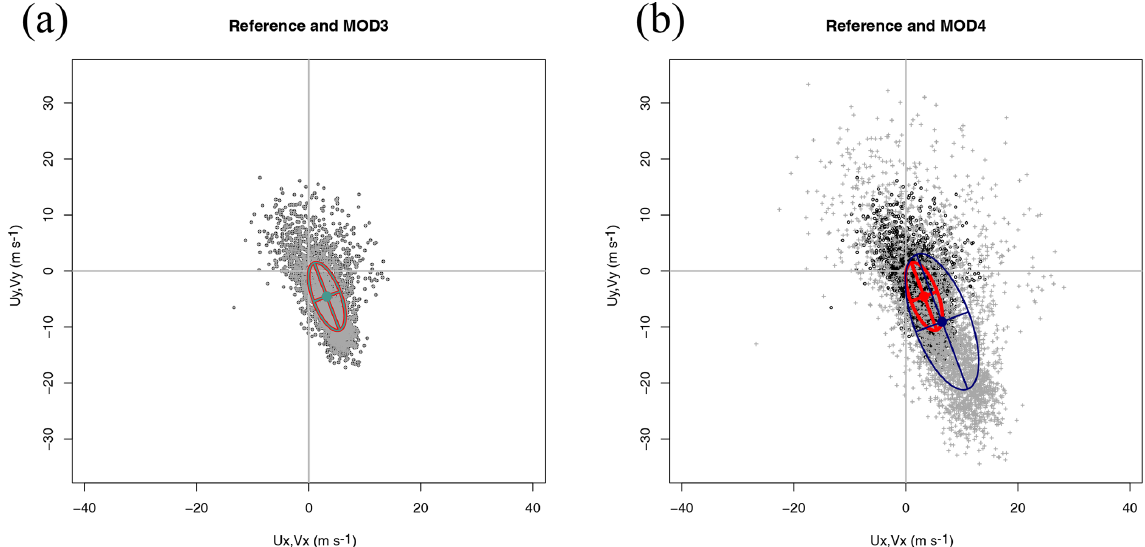
Figure 3. Scatterplot of wind in datasets Ref (panel a , black circles) and MOD3 (panel a , grey crosses) and their decomposition in terms of the principal axes corresponding to the covariance matrix of the zonal and meridional components of each dataset. The comparison of the reference dataset (black circles) with model MOD4 (grey crosses) is shown in panel (b)